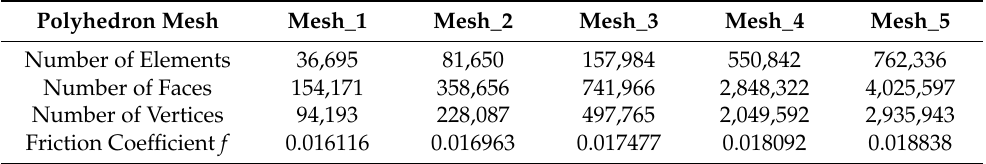
Table 2. Polyhedral mesh independent analysis. Polyhedron